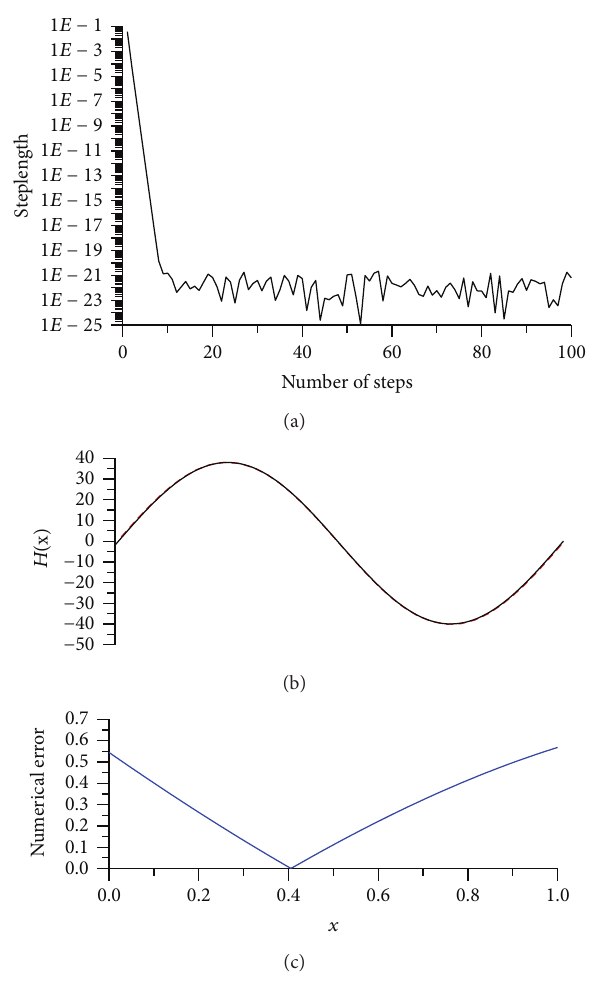
Figure 8: Example 6 showing (a) steplength of OGSDA, (b) comparing numerical and exact solutions, and (c) numerical error of